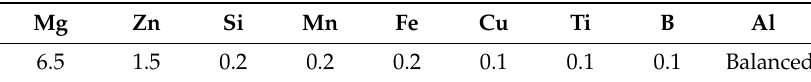
Table 1. Chemical composition of the Al 5XXX alloy (all in wt %).